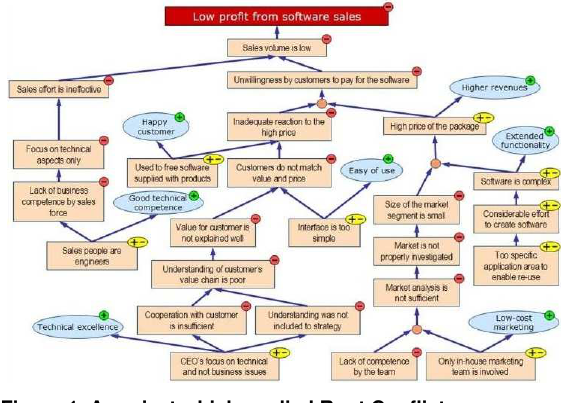
Figure 1. A project which applied Root Conflict Analysis(RCA+) to formulate the problem [29]